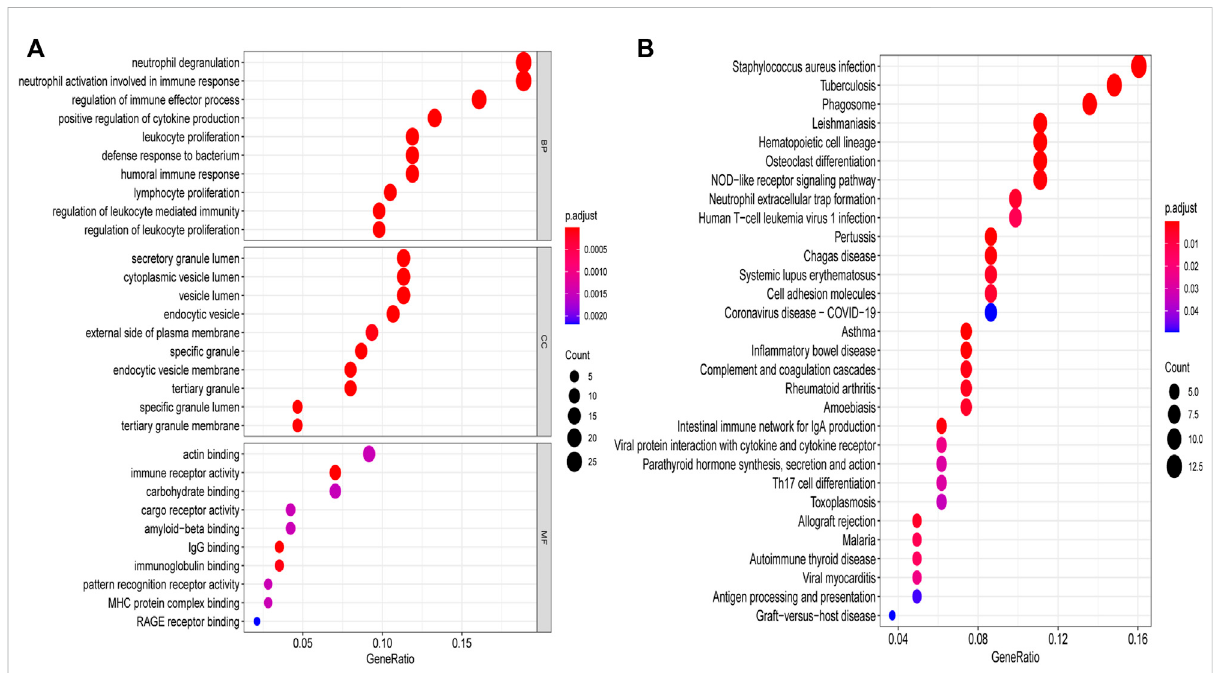
FIGURE 2 GO and KEGG analyses of DEGs. (A) GO enrichment analysis, bubble plot of the functional enrichment analysis including BP, CC, and MF. (B) KEGG enrichment analysis, bubble plot of the functional enrichment analysis. GO, Gene Ontology; KEGG, Kyoto Encyclopedia of Genes and Genomes; DEGs, differentially expressed genes; BP, biological processes; CC, cellular component; MF, molecular